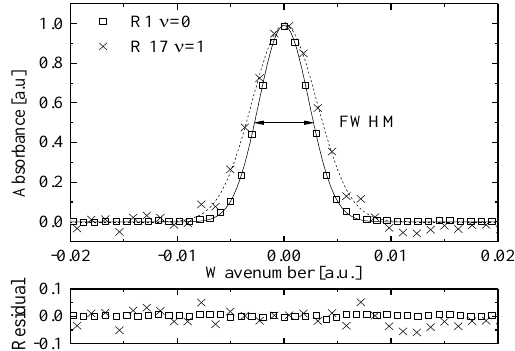
Figure 35. Experimental data of absorption lines of CO, R(1) of the ground state and R(17) of the first hot band, together with Gaussian fits for temperature determination. The lines are superposed in position and normalized in intensity in order to compare their relative broadening, p = 0.35 mbar, P = 3 kW, φ = 50 sccm, CH 4 admixture: 2.5%, CO 2 admixture: 1% [66], © IOP Publishing. Reproduced with permission. All rights reserved. Photonics 2016 , 3 , 45